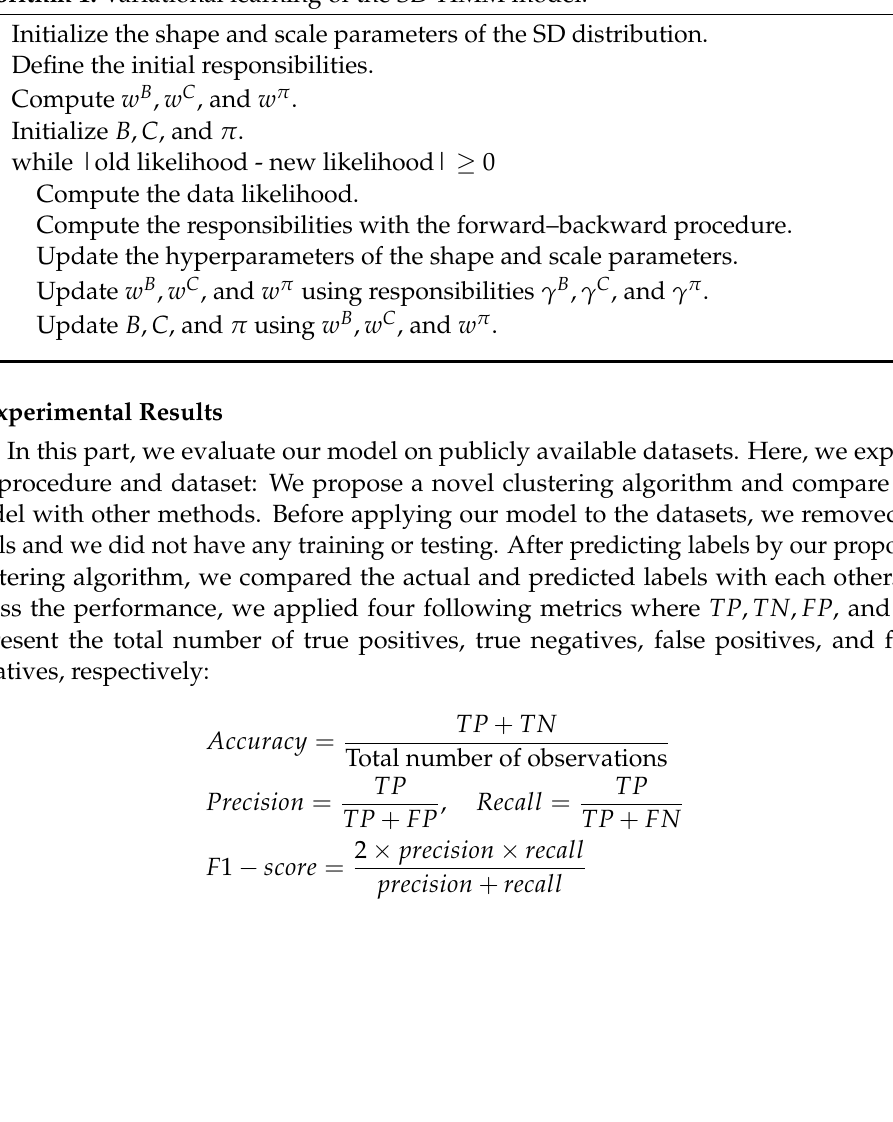
Algorithm 1: Variational learning of the SD-HMM